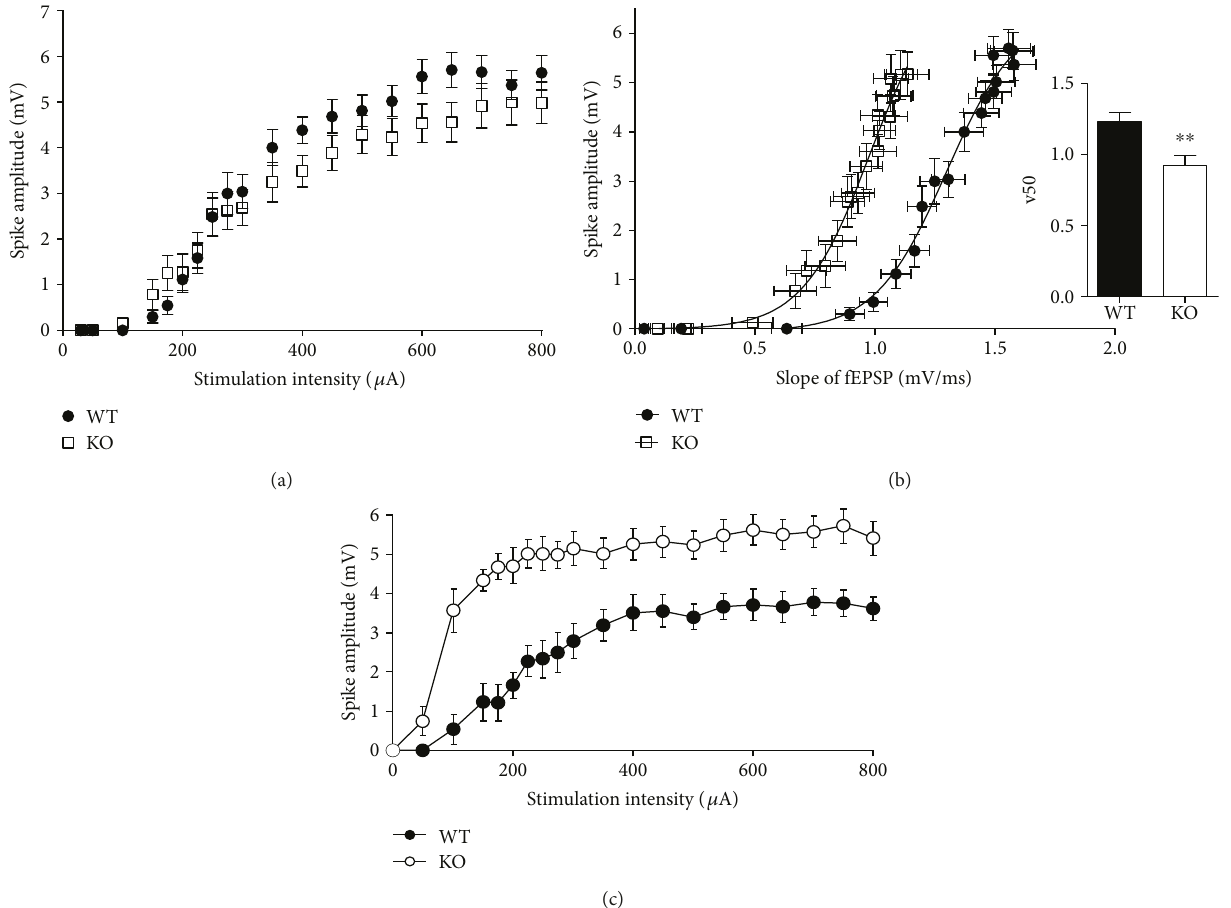
Figure 3: The in fl uence of NL1 and NL2 on synaptic transmission and granule cell fi ring. (a) Normal granule cell fi ring in the NL1-de fi cient dentate gyrus. Population spike is a measure of granule cell fi ring. Input-output relationship for population spike amplitudes recorded in WT and NL1 KO mice was not changed indicating similar capability for generating action potentials. (b) EPSP-spike (ES) analysis revealed enhanced coupling between the slope of the fEPSP and the amplitude of the corresponding population spike evoked by perforant path stimulation. Inset: a signi fi cant (unpaired t -test, ∗∗ p < 0 01 ) decrease in the slope generating 50% of maximal spike amplitude (v50)